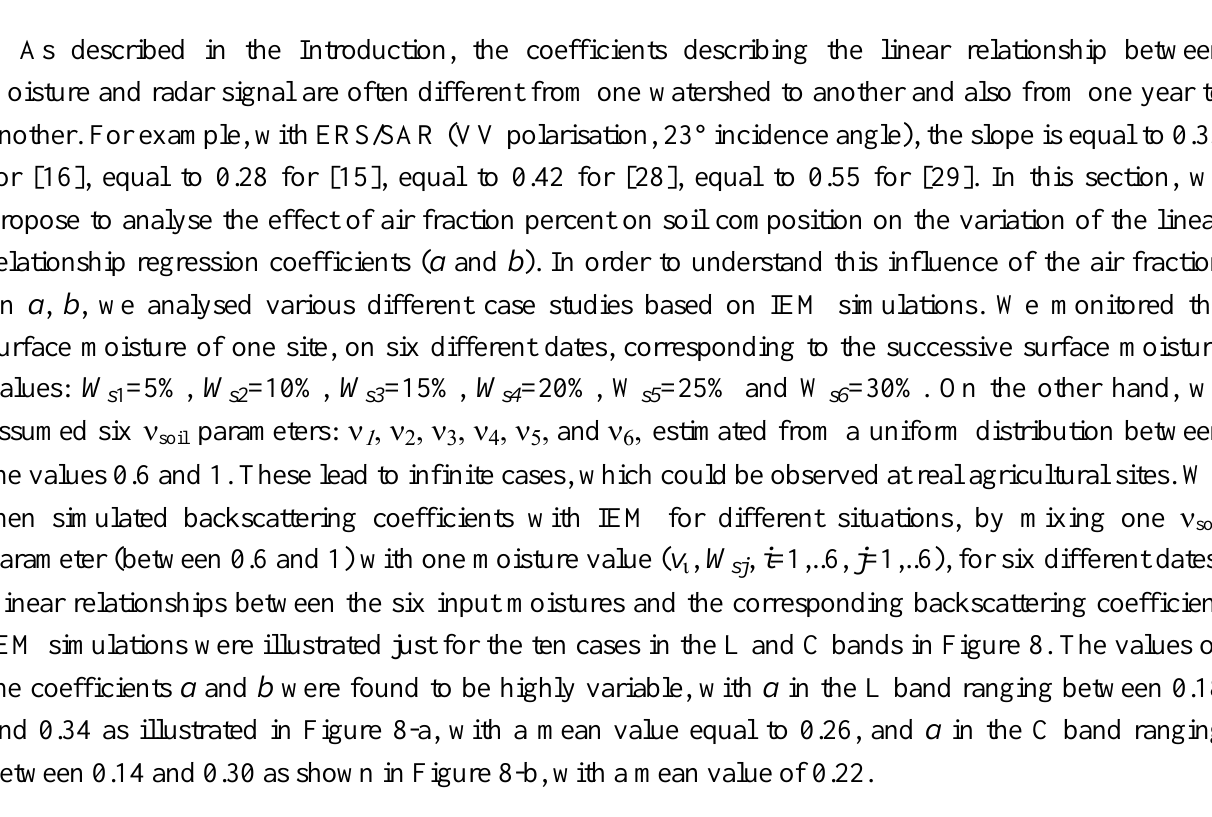
Figure 8. Illustration of the effects of air fraction on the linear relationship between soil moisture and simulated radar signals, lines corresponding to ten linear relationship cases, with for each one, as input, successive surface moisture values (5%, 10%,15%, 20%, 25% parameters (  and 30%) with six       and   estimated from a uniform       soil distribution between the values 0.6 and 1. (a) L band (1.25 GHz), (b) C band (5.3 GHz).